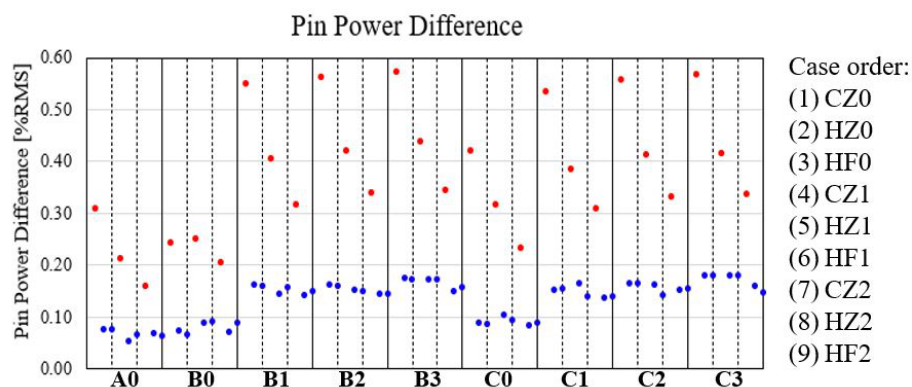
Figure 15. %RMS pin power differences for each 2-D assembly case and list of the case order within each assembly